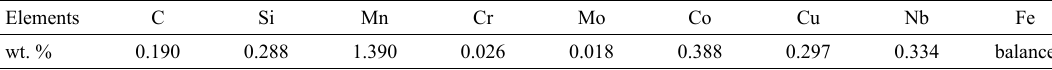
Table 1. Composition of steel panels used for the electrochemical test